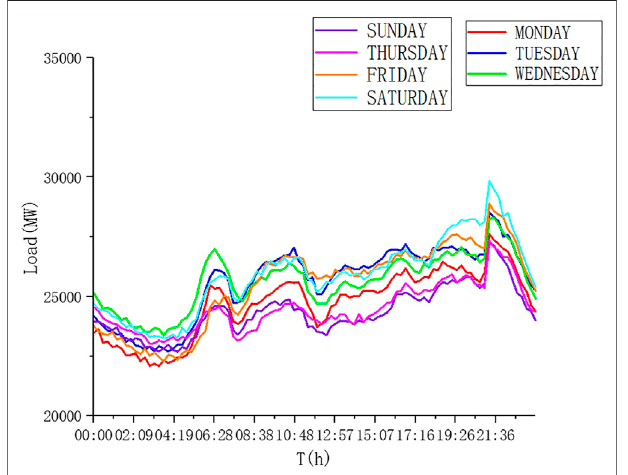
FIGURE 3 | Load forecast and actual value comparison